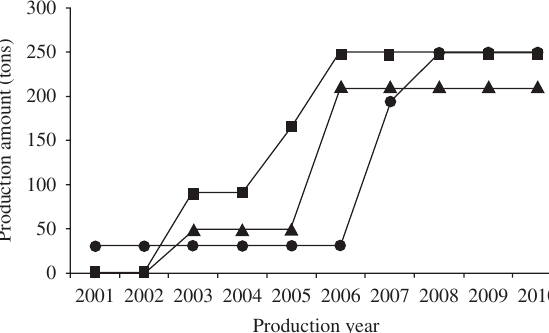
FIGURE 6: Estimates of China POSF production by three different sources. Square: Liu et al. [85]; Triangle: China MEP 2008 [9]; Circle: Yu 2010